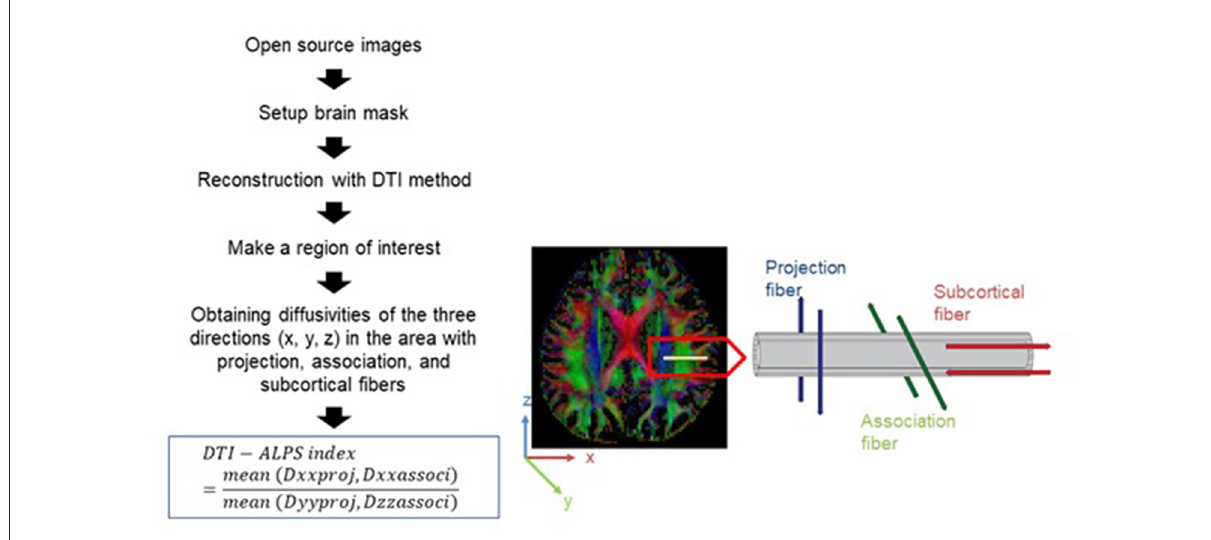
FIGURE1 Diagram depicting how the diffusion tensor image analysis along the perivascular space (DTI-ALPS) index is calculated